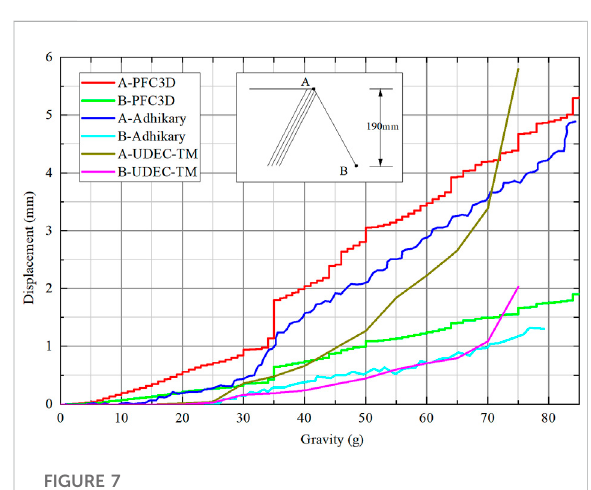
FIGURE 7 DisplacementcontrastwithAdhikary ’ stestandtheUDEC-TM